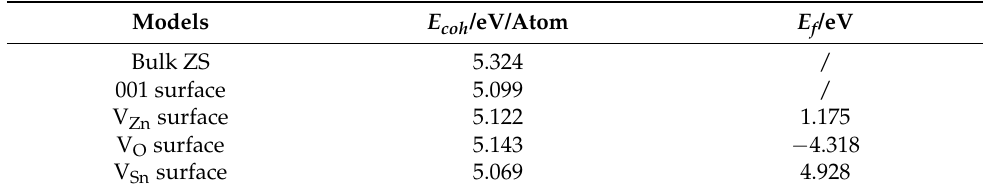
Table 2. Cohesive energy and defect formation energy of ZnSnO 3 bulk; perfect 001 surface; and surfaces with V Zn , V O , and V Sn